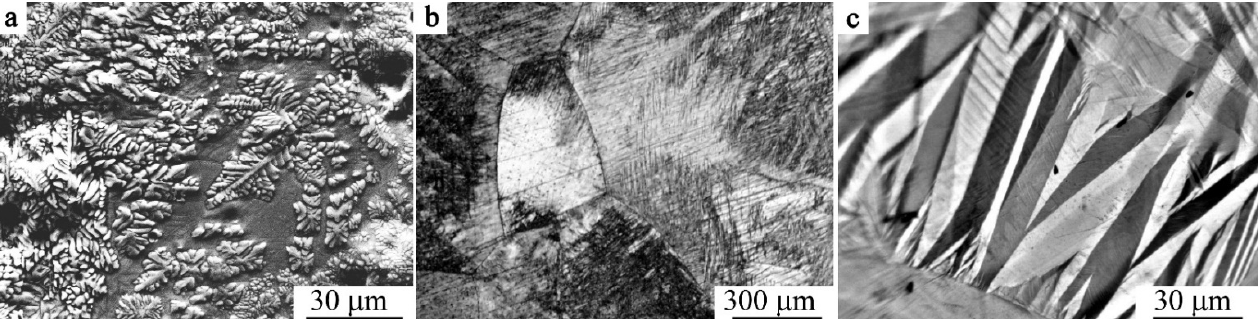
Figure 2. ( a ) SEM image in an electron back scattering (EBS) mode and ( b , c ) OM images of the alloys